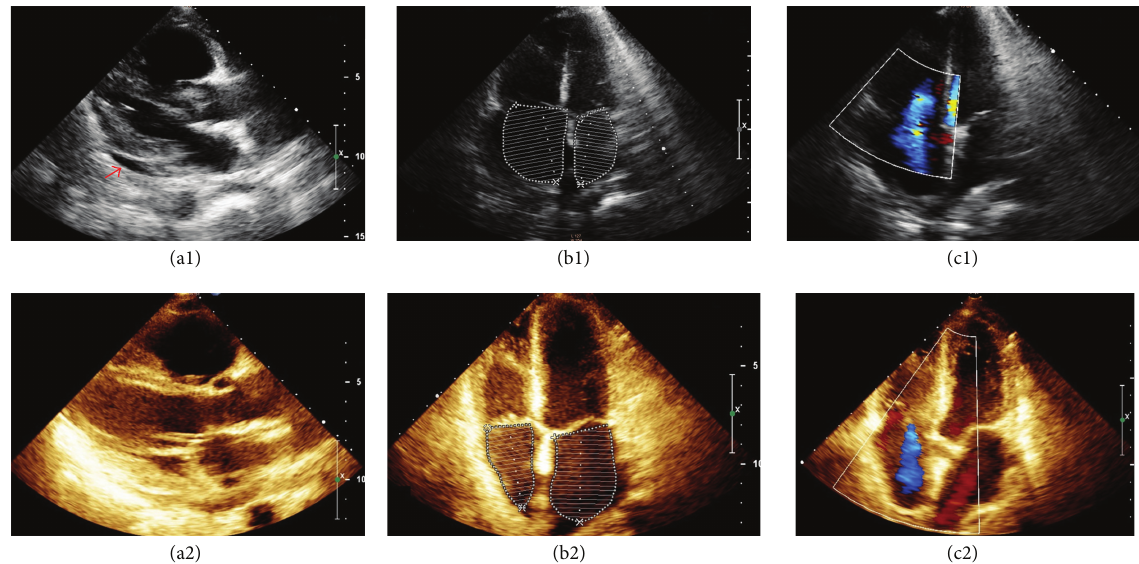
Figure 1: Transthoracic echocardiogram. (a1) Long parasternal axis showing pericardial effusion (arrow); (a2) one week later showing resolution of pericardial effusion; (b1) four-chamber view showing marked right atrial dilatation; (b2) four-chamber view one week later showing normalization of right atrial size; (c1) color doppler showing moderate tricuspid regurgitation; (c2) color doppler one week later showing a decrease in tricuspid